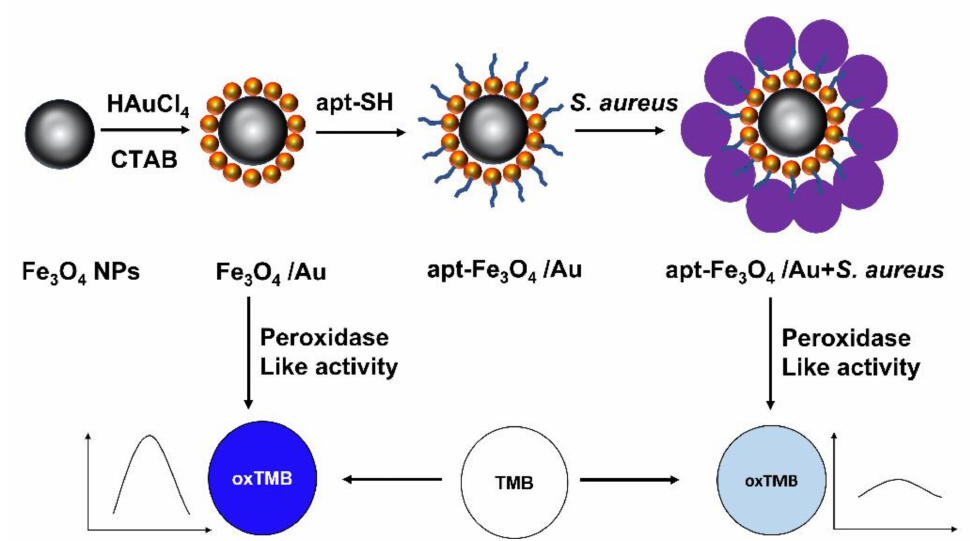
Figure 14. The scheme of colorimetric detection of S. aureus using peroxidase-like activity of Fe 3 O 4 NPs/AuNPs nanocomposite modified by thiolated DNA aptamers (apt-SH) at presence of TMB and H 2 O 2 . Hexadecyl trimethyl ammonium bromide (CTAB) has been used for decoration of Fe 3 O 4 NPs by AuNPs. Reprinted with permission from ref. [138]. Copyright 2021,